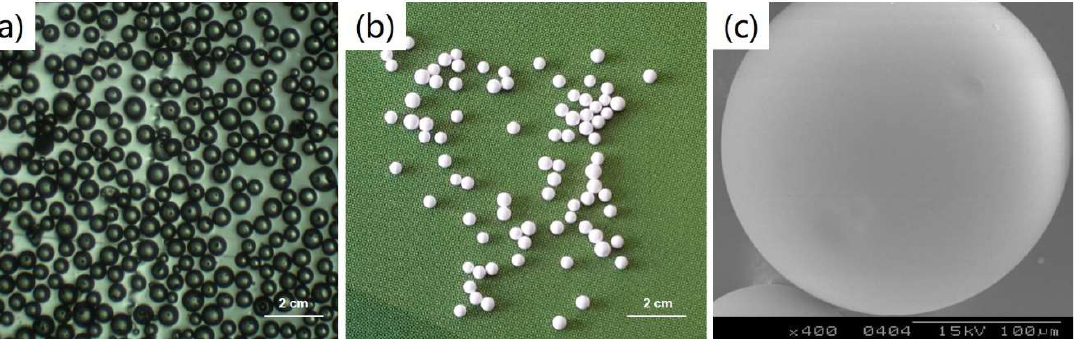
Figure 1. The optical micrograph ( a ), digital photograph ( b ), and SEM micrograph ( c ) of PLGA microspheres.